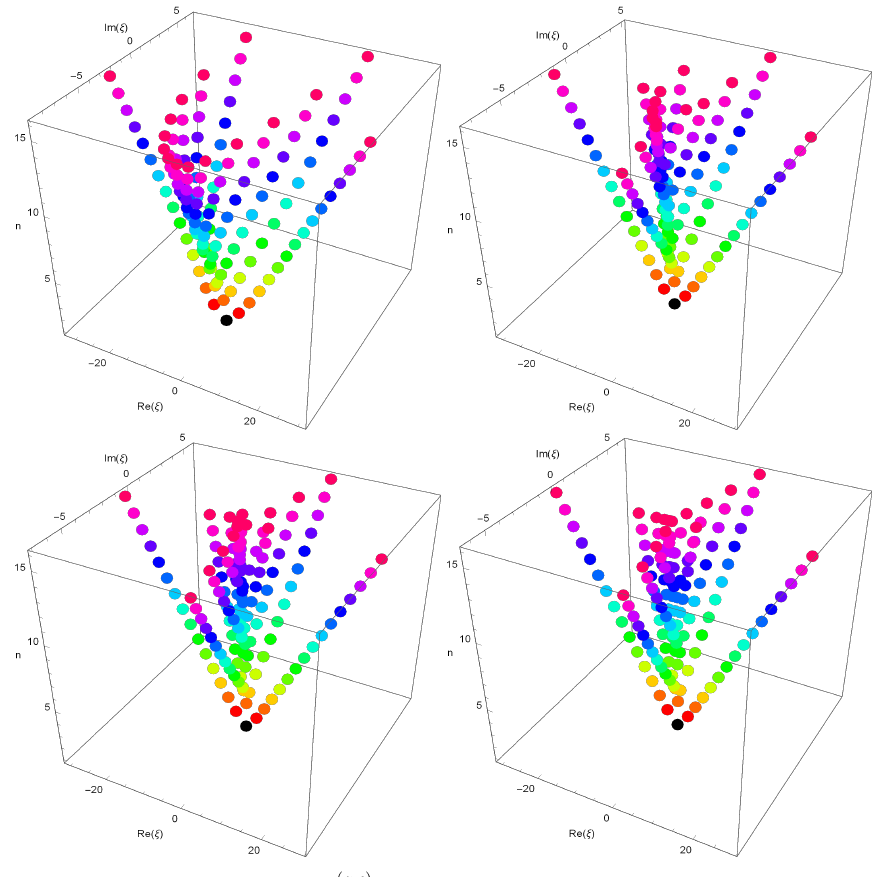
Figure 3. Stacks of zeros of Bel H The plots of real zeros of Bel H (Figure 4).